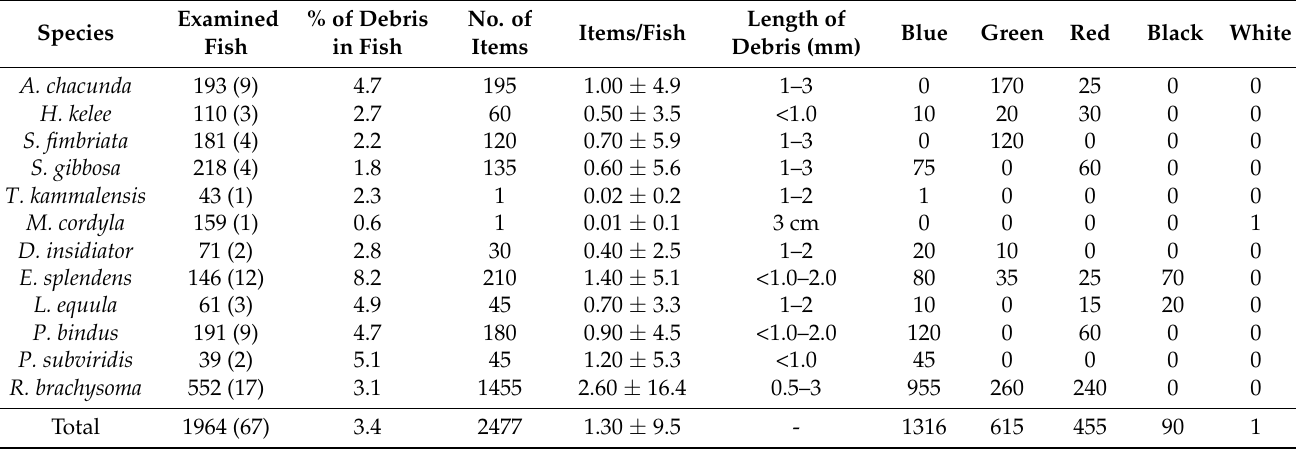
Table 4. Abundance of ingested anthropogenic debris by number and colour in the 12 marine fish species of non-empty-stomach fish. Parentheses enclose the number of fish with ingested